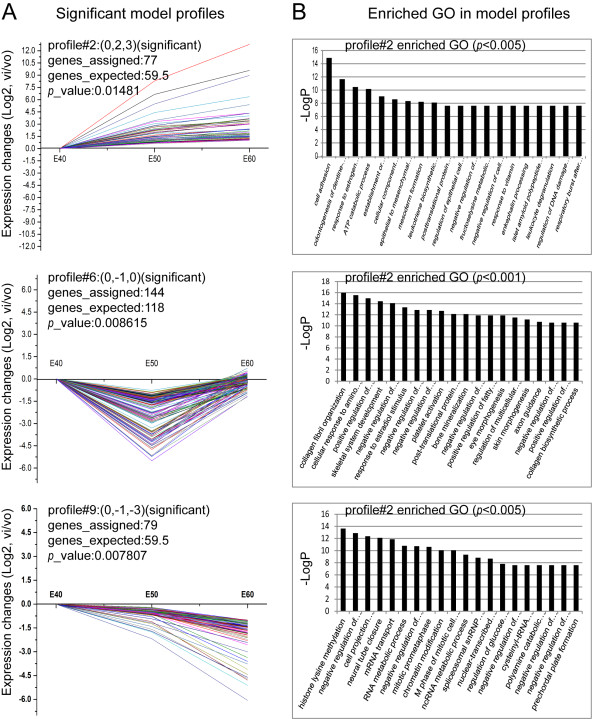
Significant gene expression tendencies and GO enrichment of profiles 2, 6 and 9. (A) The significant gene expression tendencies of profiles 2, 6 and 9. (B) The significant enriched GO terms in profiles 2, 6 and 9. The 77 genes in profile 2, which consistently increased in expression, closely correlated with odontogenesis. STC-GO analysis showed genes were involved in cell adhesion, odontogenesis of dentine-containing teeth, establishment or maintenance of cell polarity, cellular component movement, epithelial to mesenchymal transition, regulation of epithelial cell migration, mesenchyme development, BMP signaling pathways, tooth mineralization, positive regulation of apoptosis, enamel mineralization, positive regulation of tooth mineralization, and organ morphogenesis.